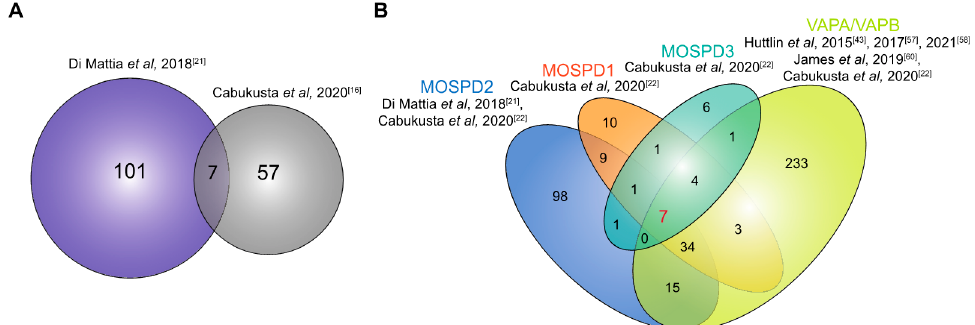
Figure 5. Interactome of the MOSPD proteins. ( A ). The overlap of proteins interacting with MOSPD2 as identified by Di Mattia et al. [21] and Cabukusta et al. [22]. The overlapping proteins are RAB3GAP1/2, CCDC47, RMDN3, ACSL3, FAF2 and TMPO. ( B ) Venn diagram showing the overlap of interacting partners of all five proteins of the VAP family. The proteins interacting with MOSPD2, MOSPD1, MOSPD3 and/or VAPA/VAPB were identified by Di Mattia et al. [21], Cabukusta et al. [22], Huttlin et al. [43,57,58], James et al. [60], as indicated. The seven proteins shown to interact with all proteins are TACC1, FNDC3A, ESYT1, ESYT2, ANKLE2, ZC3HAV1 and EIF2AK3.